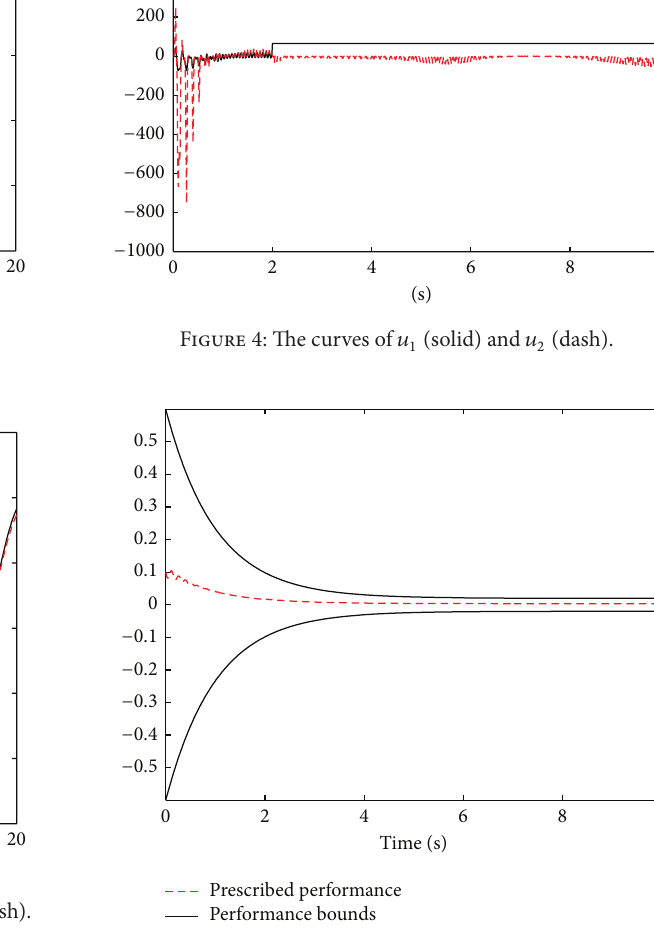
Figure 5: The curves of 𝑧 1 and performance